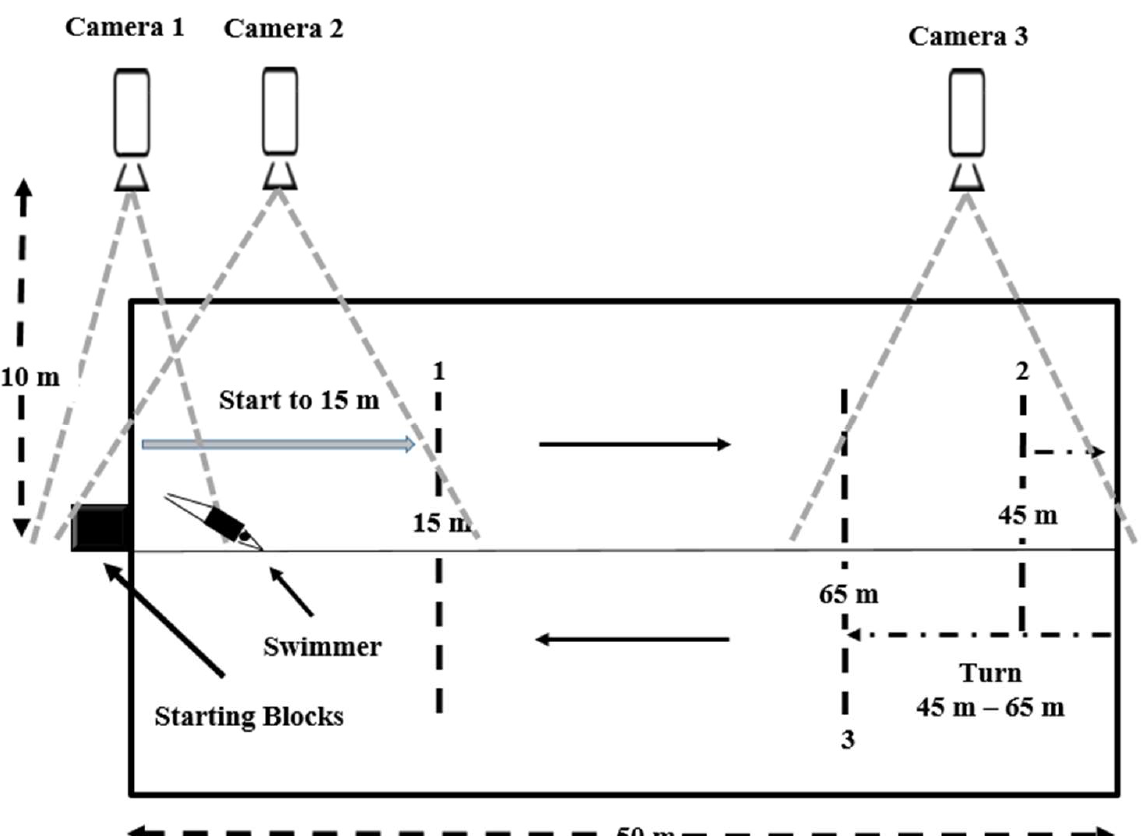
Figure 3. Set-up to analyze the start and turn performances.